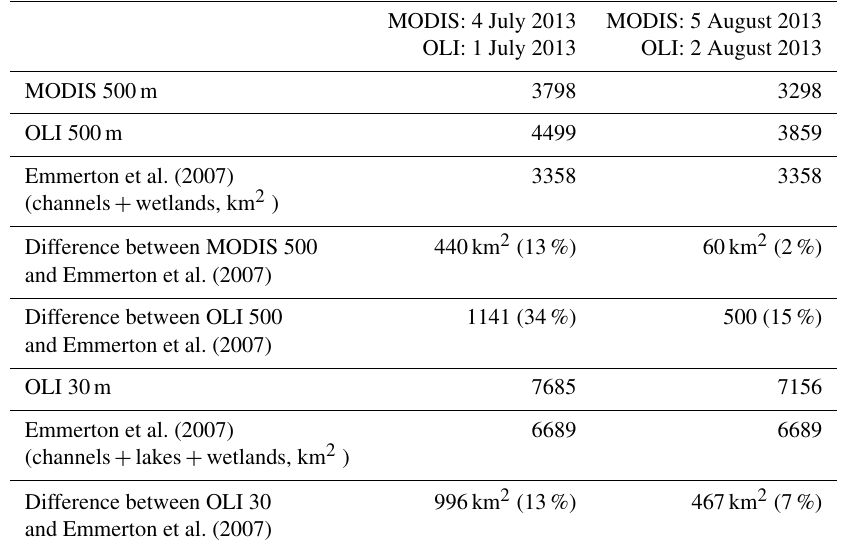
Table 1. Validation of surface water extents (km 2 ) determined using OLI 30m, OLI 500m, and MODIS 500m images with the results of Emmerton et al. (2007).